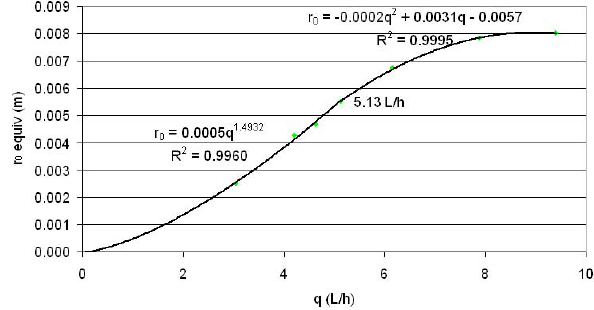
Fig. 6. Fitting equations used in the